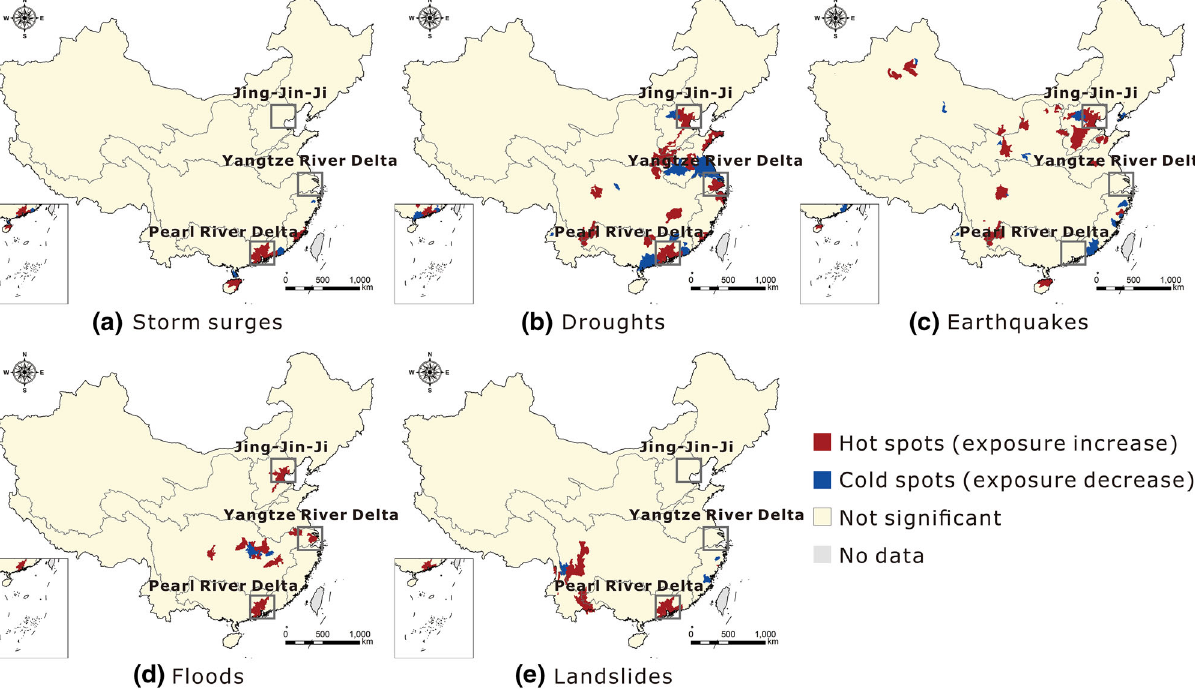
Fig. 4 Hot/cold spots of changes in population exposure to hazards in China from 2005 to 2015. Jing-Jin-Ji: Beijing–Tianjin–Hebei